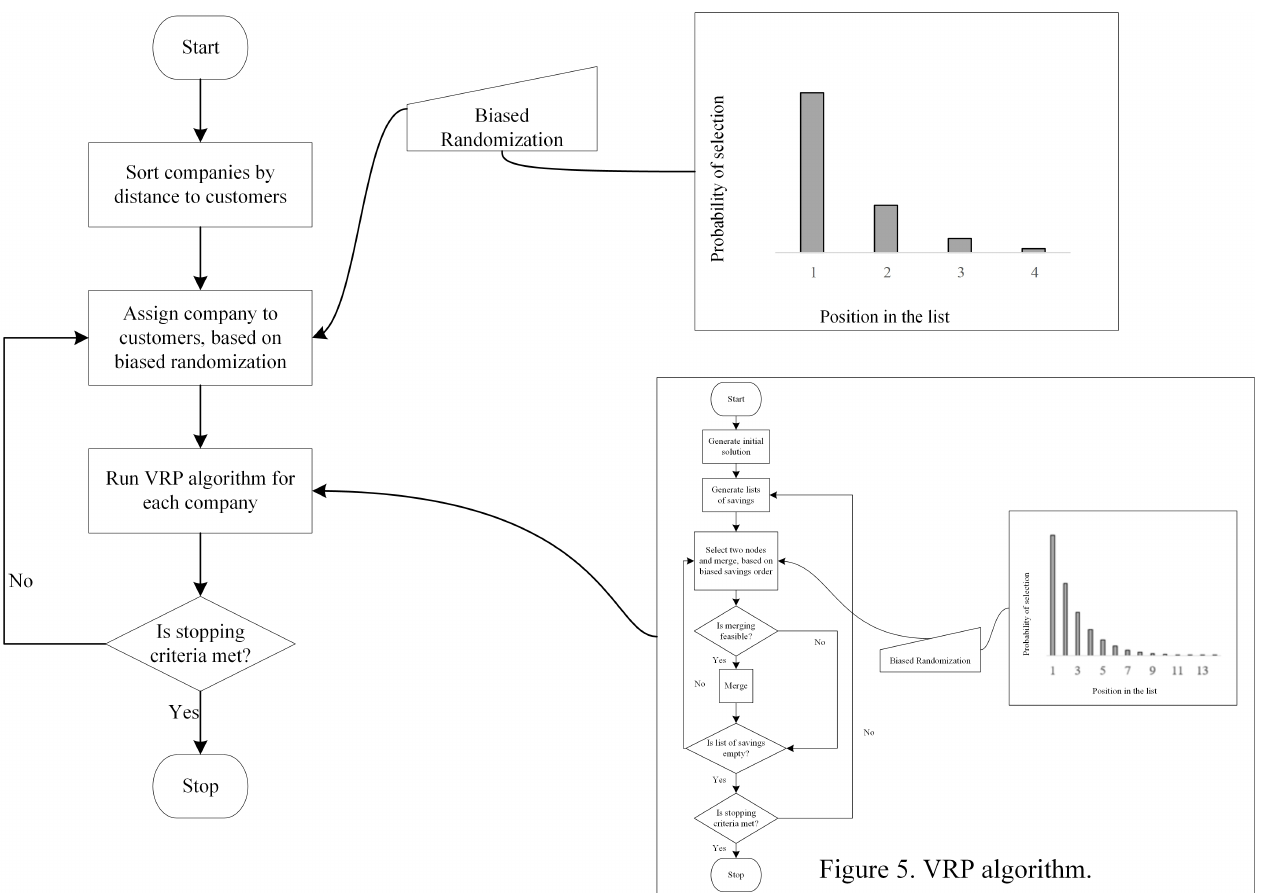
Figure 7. Flowchart of the proposed algorithm for solving the Multi Depot VRPs